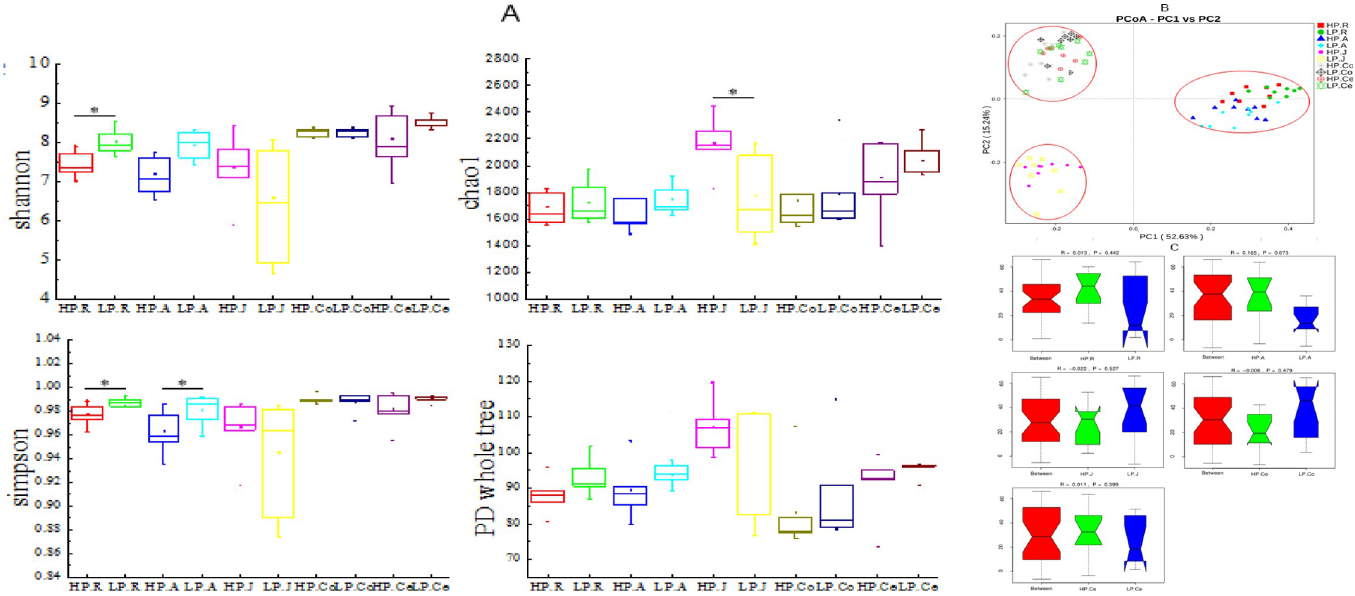
Fig 2. A: Comparison of alpha diversity indices between the HP and LP groups. Error bars represent the SD of two samples. Asterisks show significant differences between groups ( � P < 0.05), the same as below. B: Principal coordinate analysis of bacterial samples from the gastrointestinal tract. A greater distance between two samples indicated a lower similarity. The percentage of variation explained by PC1 and PC2 are indicated on the axis. C: A microbial analysis of similarities (ANOSIM). R was the mean rank of between-group dissimilarities, ranging from -1 to 1. When the R value is greater than 0, the difference between groups is greater than that within groups, indicating that there are differences between groups; when the P value is less than 0.05, it indicates significant differences between groups. HP.R: rumen of HP; LP.R: rumen of LP; HP.A: abomasum of HP; LP.A: abomasum of LP; HP.J: jejunum of HP; LP.J: jejunum of LP; HP.Co: colon of HP; LP.Co: colon of LP; HP.Ce: cecum of HP; LP.Ce: cecum of